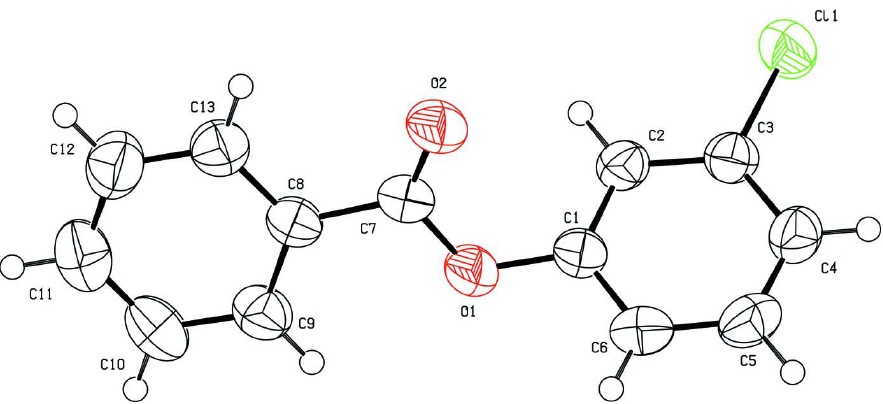
Figure 1 Molecular structure of the title compound, showing the atom labeling scheme. The displacement ellipsoids are drawn at the 50% probability level. The H atoms are represented as small spheres of arbitrary